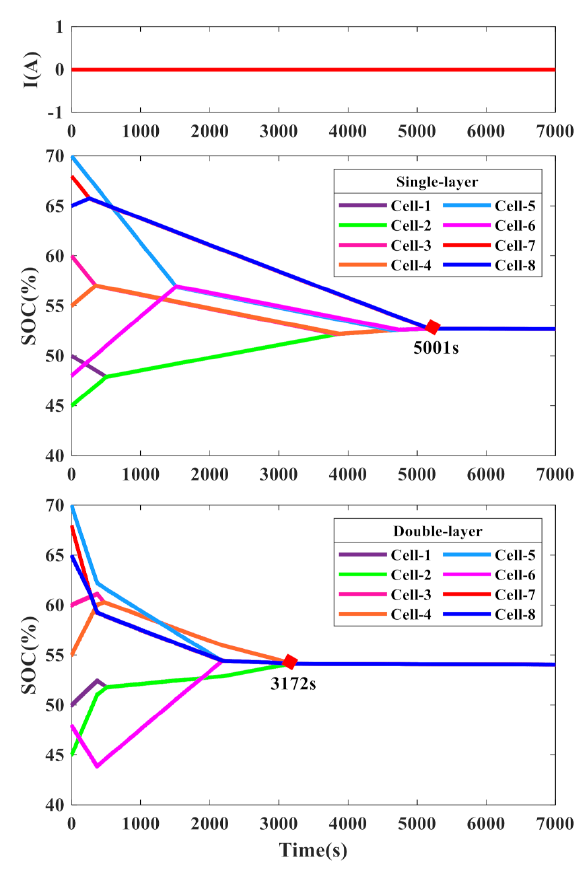
Figure 11. Static state simulation results of the two